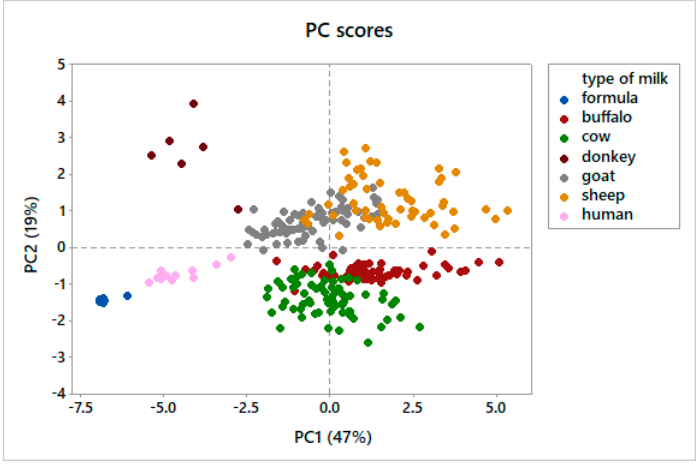
Figure 1. Score plots of the two first principal components explaining 47 and 19% of the total variance, respectively.